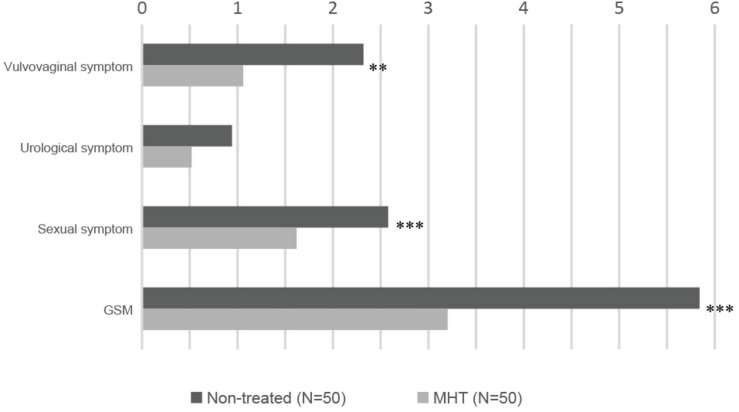
Severity of GSM main symptoms in each group: non-treated vs. MHT. Higher score means more severe symptom; statistical differences are shown in this figure: ∗∗P < 0.01, ∗∗∗P < 0.005.